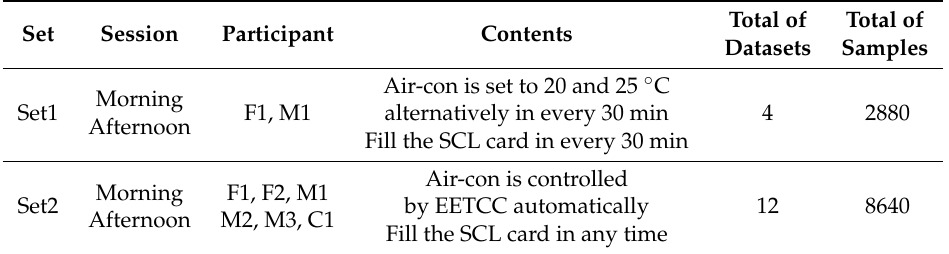
Table 6. Experiment